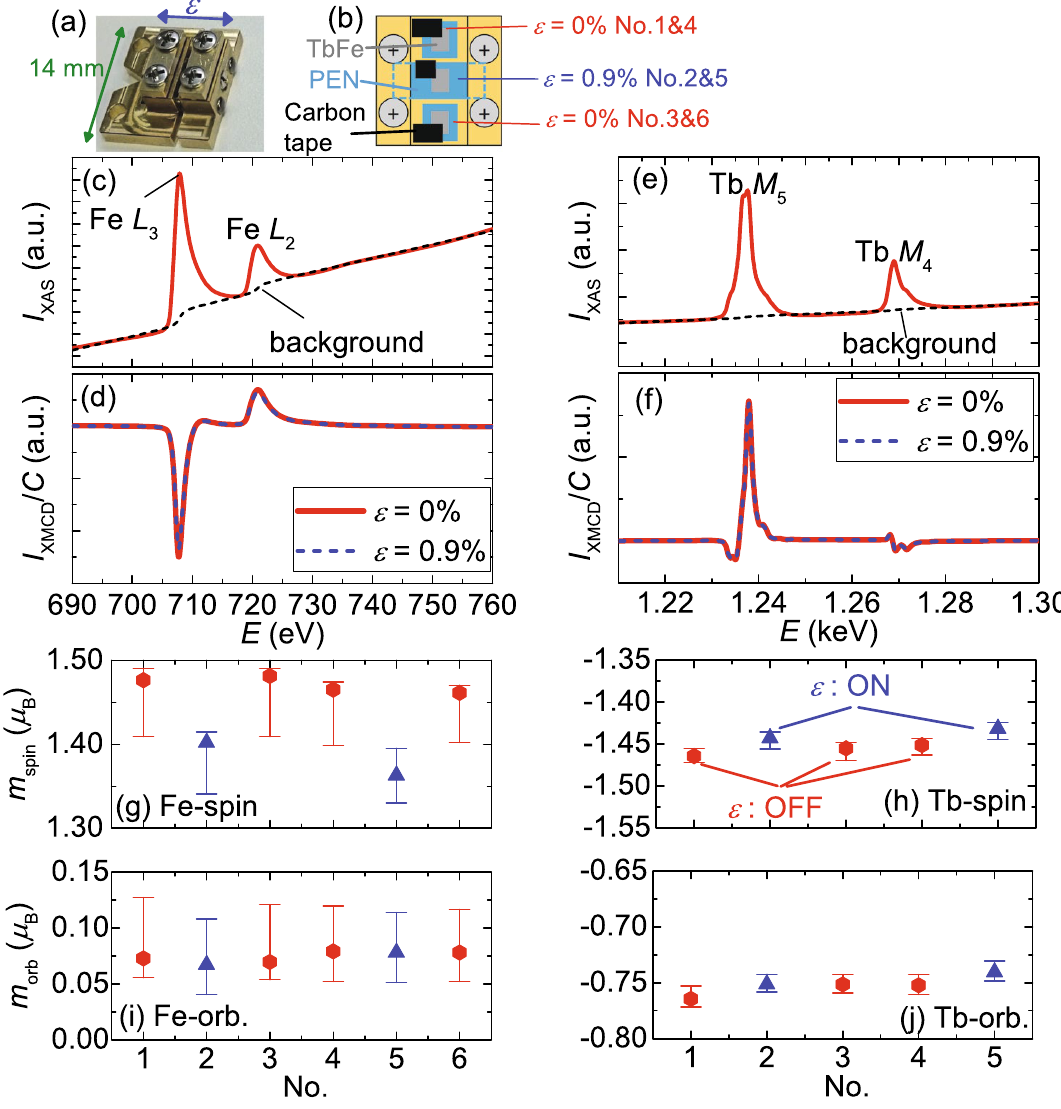
Figure 5. ( a ) Photograph of a tensile machine. ( b ) Schematics of the experimental setup. XAS and normalized XMCD around ( c , d ) Fe L 2 and L 3 edges and ( e , f ) around Tb M 4 and M 5 edges. ( g – j ) m spin and m orb of Fe and Tb obtained using sum